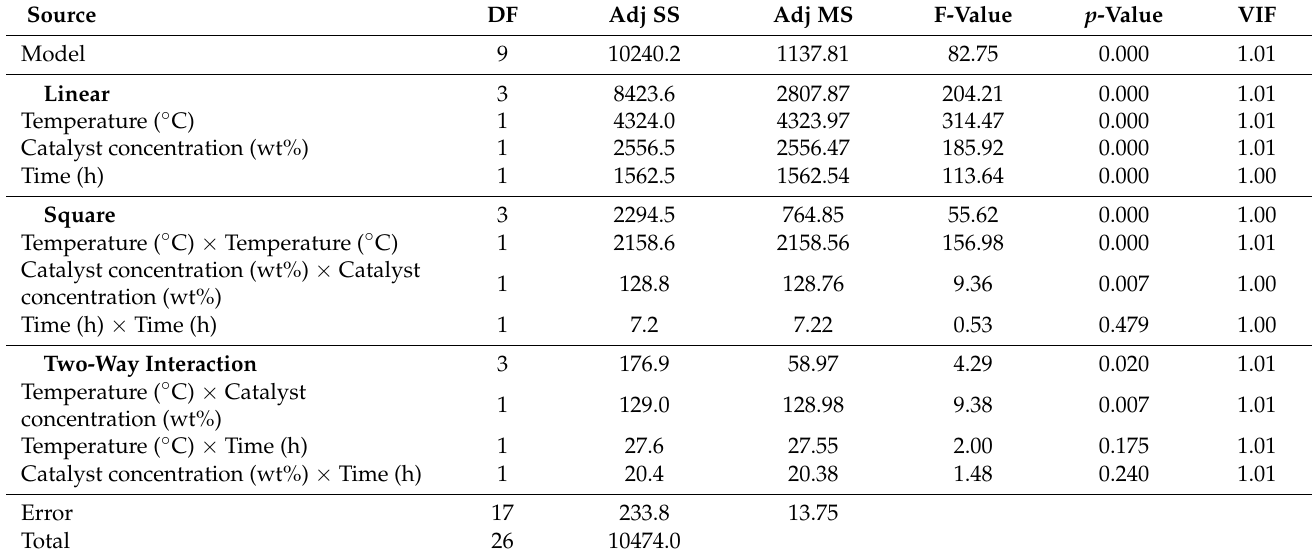
Table 2. Analysis of Variance of BP selectivity.